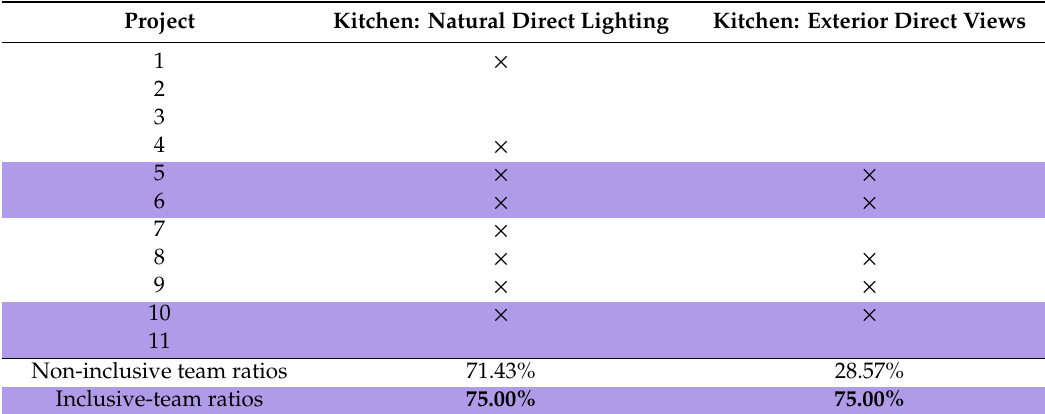
Table 3. Kitchen lighting and